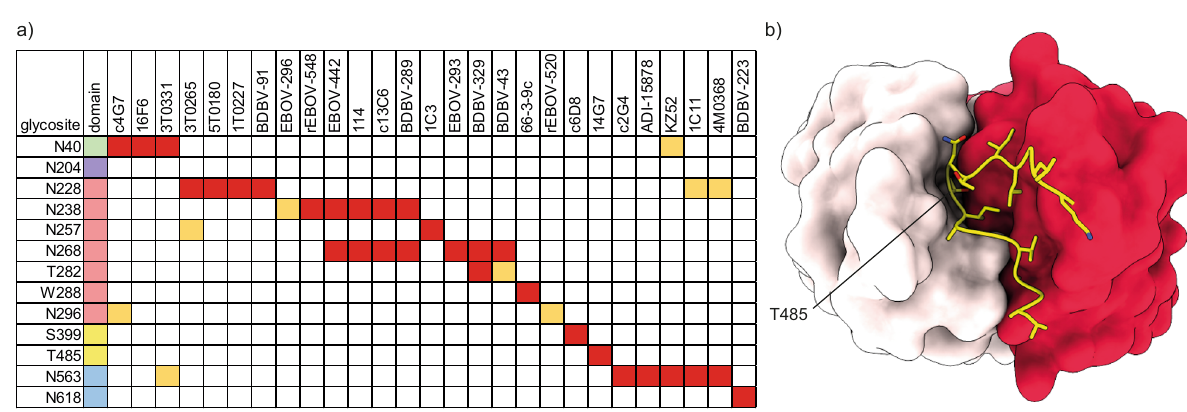
Fig. 6 Glycan-containing epitopes of monoclonal antibodies against ebolavirus GP. a Overview of glycosylation sites associated with indicated epitopes. Direct contacts and clashes with CDRs are indicated in red, brushing interactions with framework regions in light orange. b Highlighted structure of 14G7 in complex with a linear epitope from the MLD (PDB ID:2Y6S), showing that the O-linked glycosylation site T485 is deeply buried in the cleft between heavy (dark red) and light chain c6D8 binds a linear epitope that spans the O-linked glycosylation